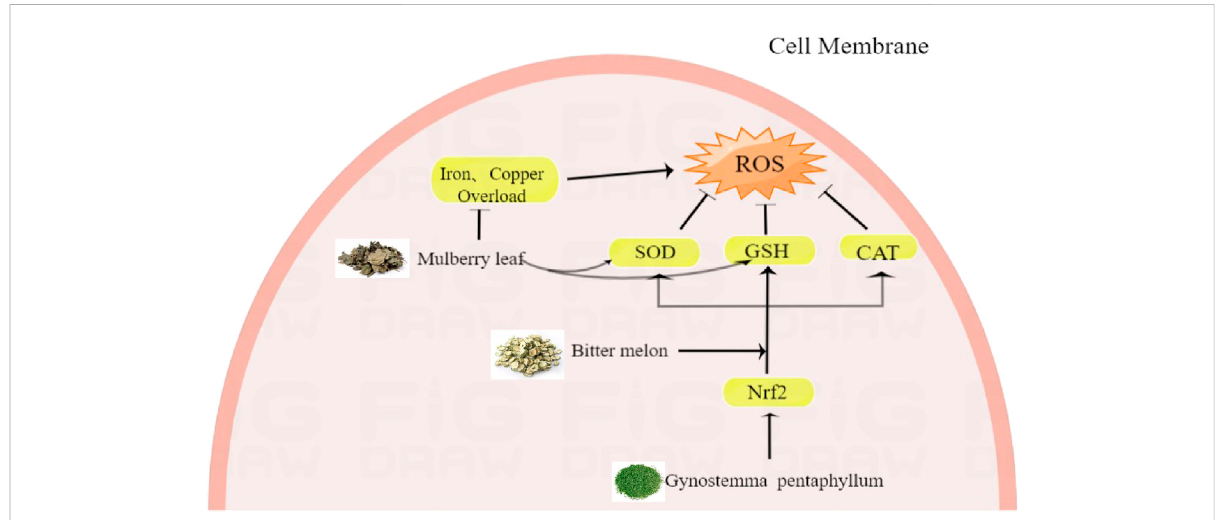
FIGURE 3 The Anti-in fl ammatory and anti-oxidant effect of herbal teas in Type 2 diabetes mellitus.